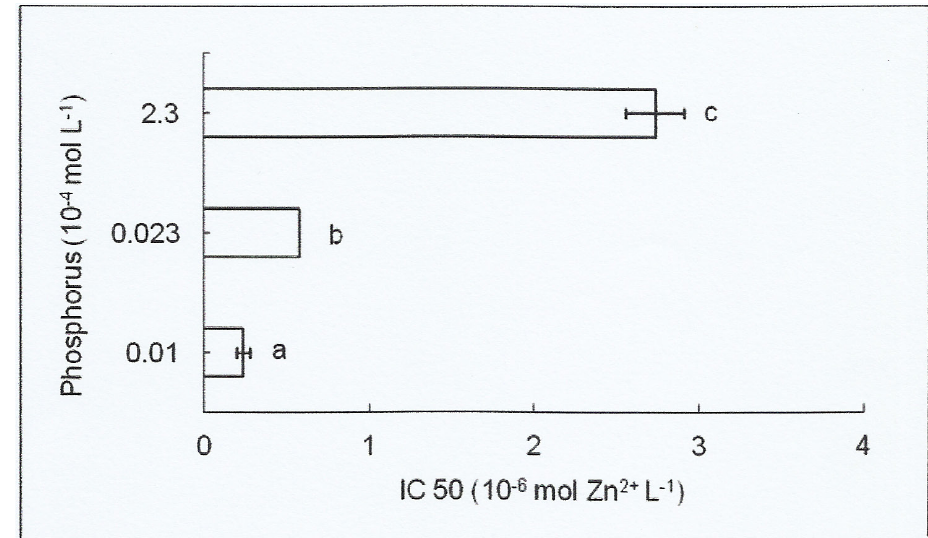
Figure 1. IC 50 values for the R. subcapitata acclimated to the phosphorus concentrations. Bars with the same letters are not significantly different (Tukey’s test, p>0.05). Values are means of three replicates (± Standard